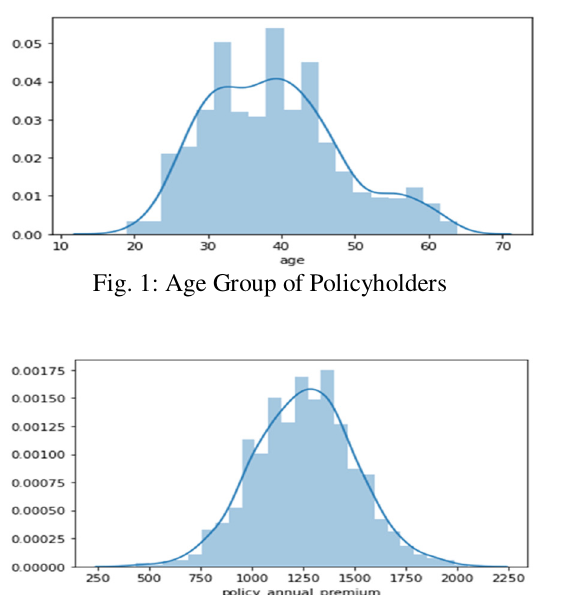
Fig. 2: Range of Policy Annual Premium Amount